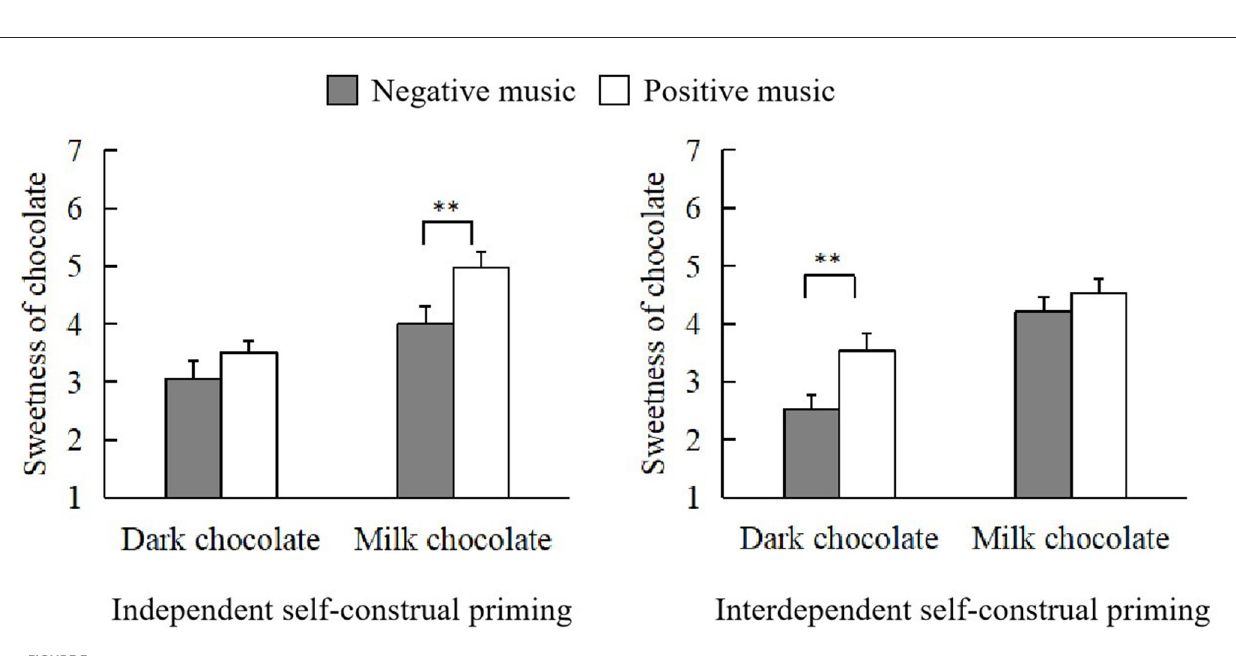
to individuals’ authentic tasting experience based on sensation transference